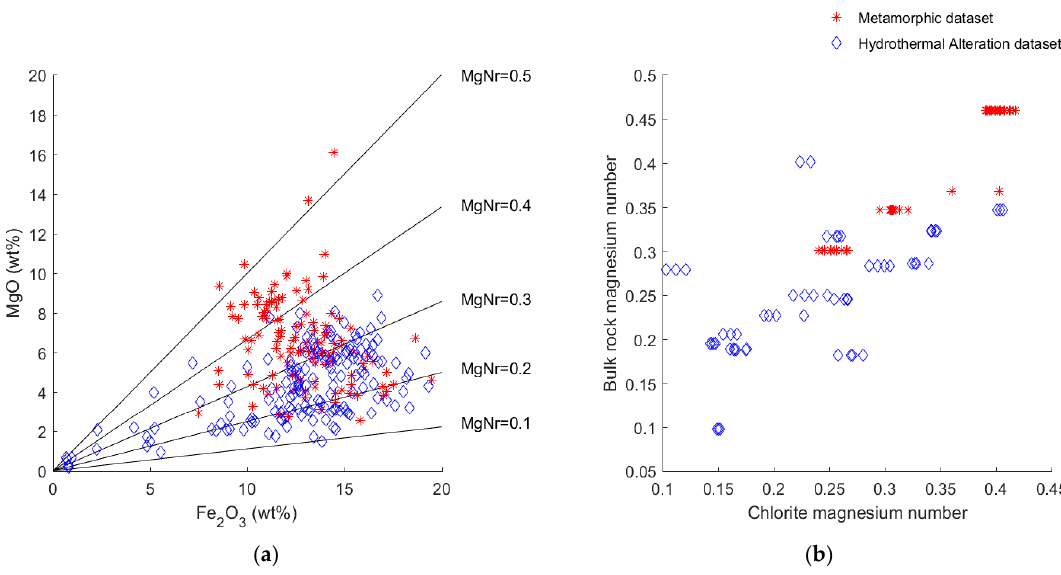
Figure 3. ( a ) Absolute bulk rock weight percentages (wt %) of MgO and Fe 2 O 3 ; ( b ) Comparison of magnesium numbers of chlorite ( x -axis) and bulk rock composition ( y -axis).